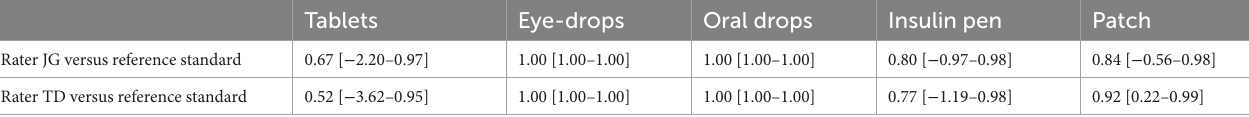
TABLE 4 Dosage form-specific interrater agreement between JG/reference standard and TD/reference